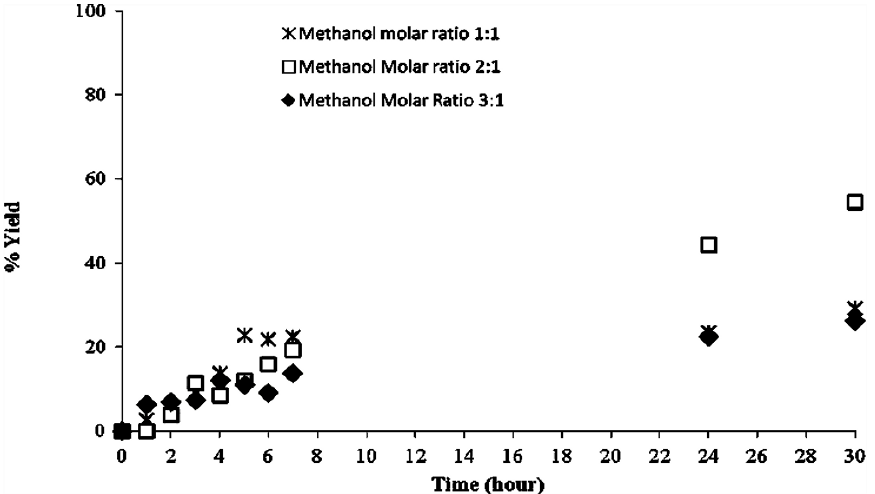
Figure 7. Effect of methanol concentration on CaL-S evaluated at 30 °C by monitoring the transesterification of triolein at different methanol/oil molar